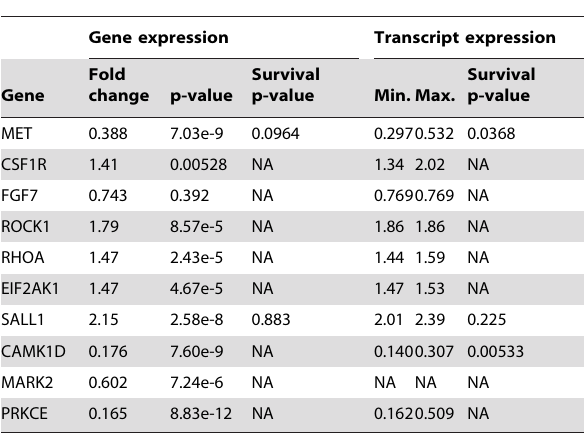
The gene expression measures the expression of the exons linked with the particular gene in Ensembl. Expression values are considered significant if the p- value is less than p , 5.00E–02. Transcript expressions are calculated from the exon expression with linear algebra-based method discussed in MEAP [13]. Minimum transcript expression denotes minimum splice variant expression and maximum transcript expression denotes maximum splice variant expression. Survival p-values were calculated from the gene expression data with Kaplan- Meier analysis. NA, Not